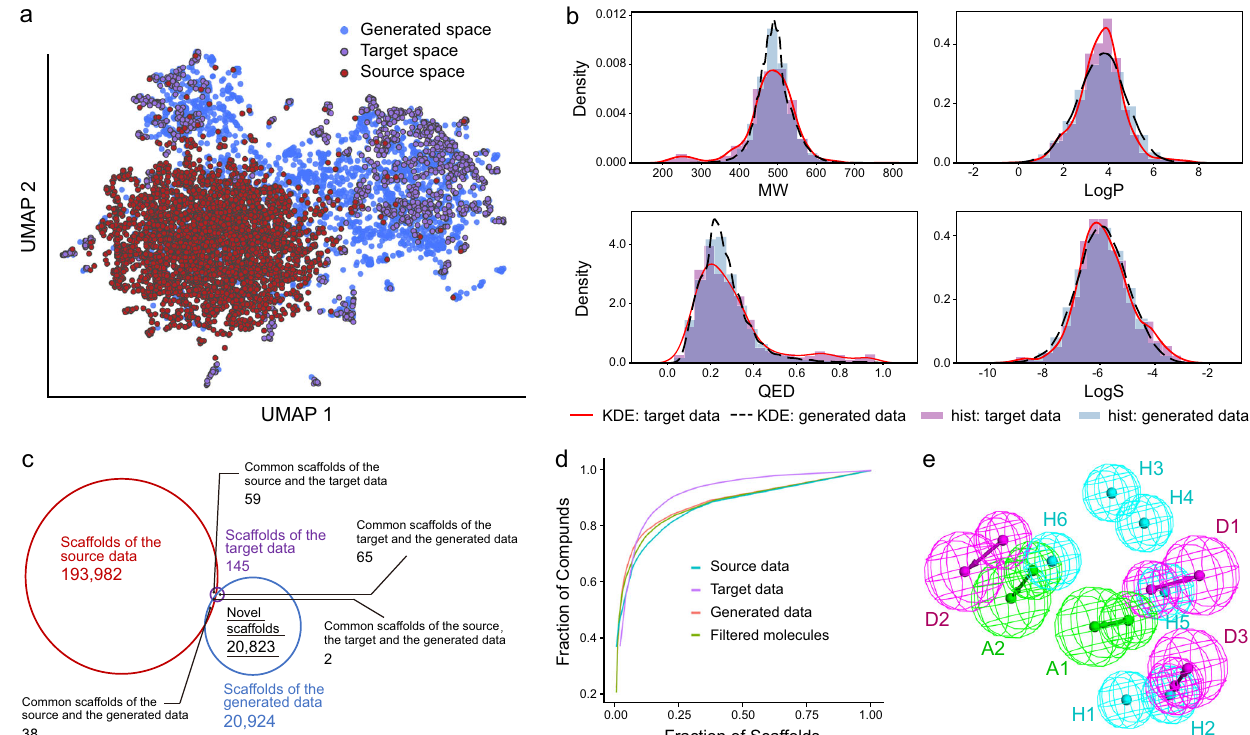
Fig.3|GenerationofavirtualcompoundlibraryagainstRIPK1usingthecRNN- based generative model. a Chemicalspace navigation by transfer learning.UMAP plots of molecule distributions of randomly selected 3000 molecules from the source data, 1000 molecules from the target data and 2000 molecules from the generated data. b The distributions of the molecule weight (MW), the water − octanal partition coef fi cient (LogP), the quantitative estimate of drug-likeness (QED), and the water solubility (LogS) of the target data and the generated data representedbythekerneldensityestimation(KDE).TheKDEdemonstrationsofthe targetdataandthegenerateddataaredisplayedbyredsolidlinesandblackdotted